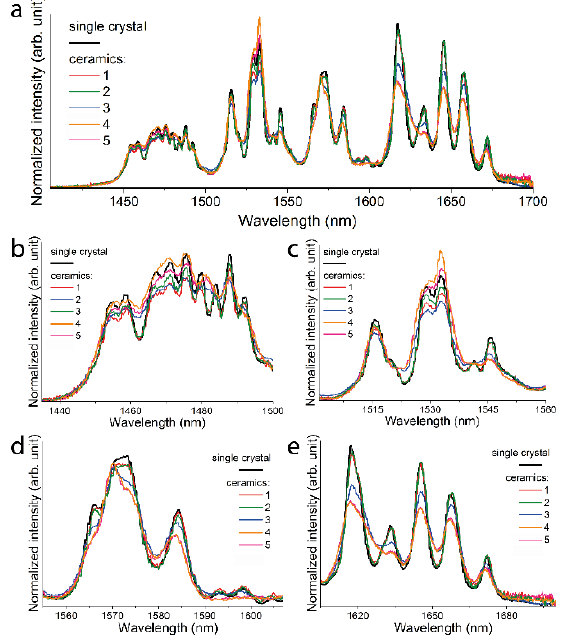
Figure 3. Room-temperature luminescence spectra of Er:YAG single crystal, Er:YAG ( S 1 , S 2 ) and Er:YSAG ( S 3 , S 4 ) ceramics measured in the range of: ( a ) 1400–1700 nm ( 4 I 13/2 → 4 I 15/2 transition), ( b ) 1440–1500 nm, ( c ) 1500–1560 nm, ( d ) 1560–1610 nm, and ( e ) 1605–1690 nm. Table 5 . Radiative decay rates ( A J → J’ ), radiative decay time 𝜏 (cid:3045)(cid:3028)(cid:3031)(cid:3030)(cid:3028)(cid:3039)(cid:3030) , fluorescence lifetime ( 𝜏 (cid:3039)(cid:3048)(cid:3040)(cid:3032)(cid:3051)(cid:3043) ), the intrinsic quantum yield ( η ), non-radiative multiphonon decay rates ( W NR ) of the 4 I 13/2 multiplet, and the values of emission cross section ( 𝜎 ) of the 4 I 13/2 → 4 I 15/2 electron transition in Er 3+ -doped YAG (YSAG) ceramics at 300 K.